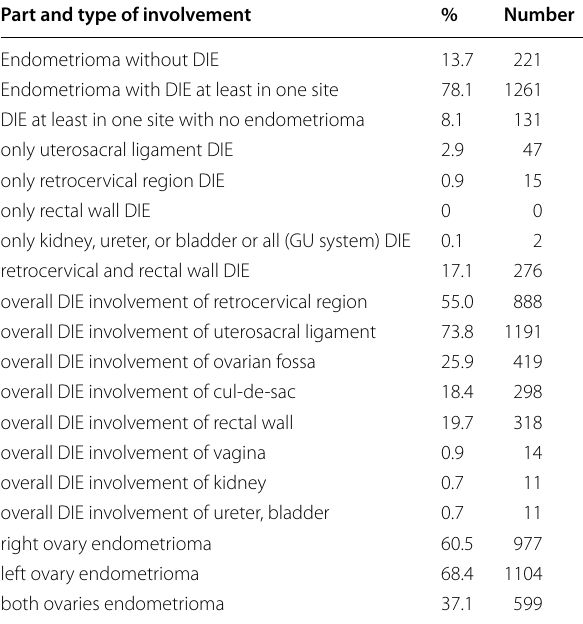
Table 3 Cases who are positive for endometriosis classified as parts that are